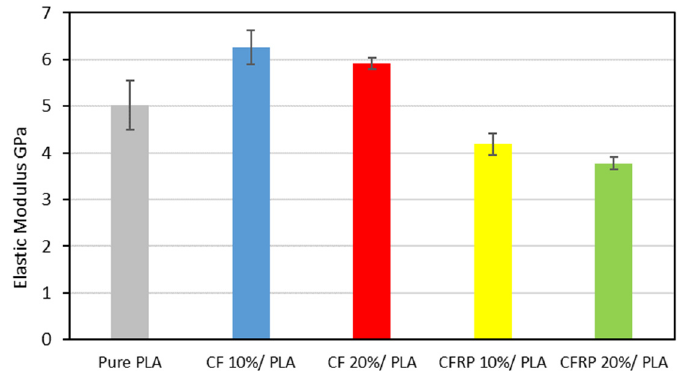
Figure 13. Elastic Modulus of the blends.